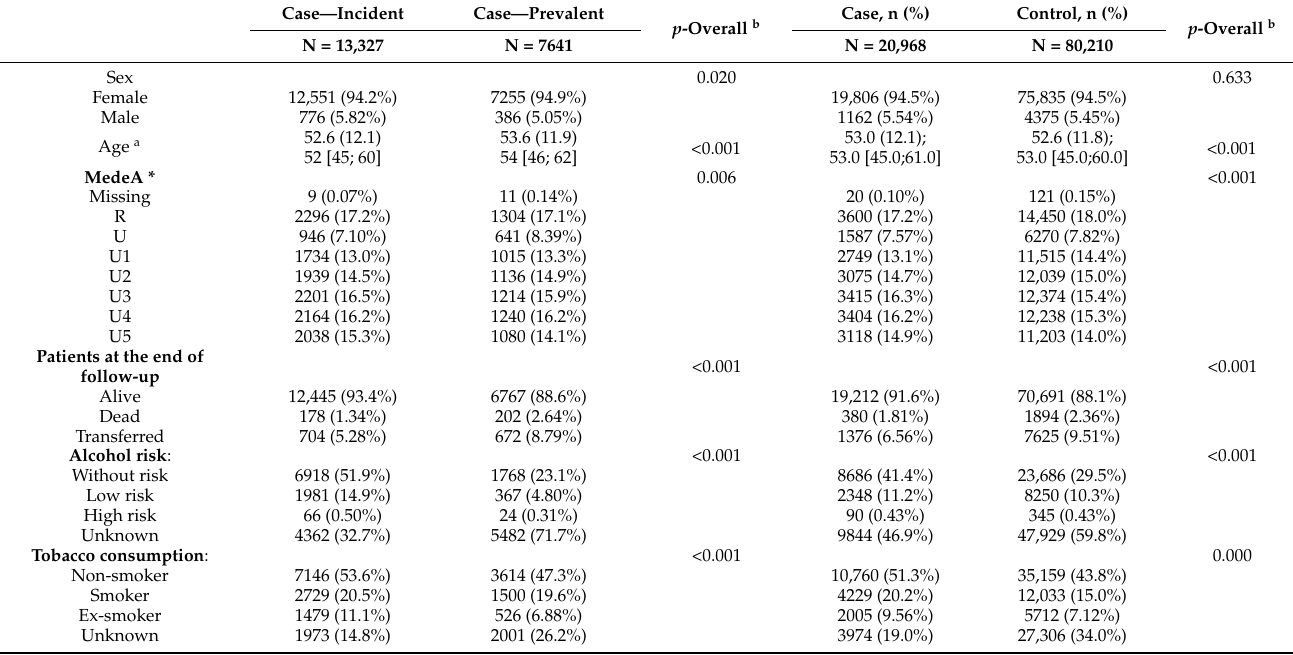
Table 1. Demographic characteristics at baseline.